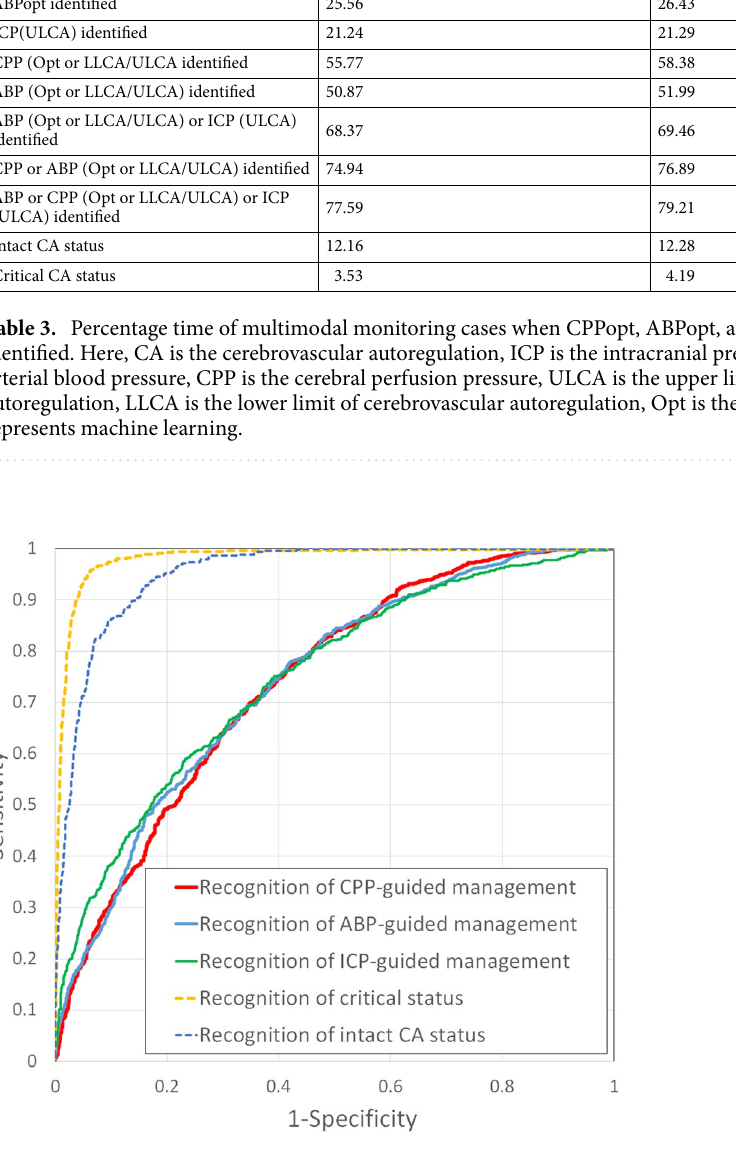
Figure 5. Representation of the diagnostic ability of the developed ML model to recognize CPP-, ABP- or ICP-guided management, as demonstrated by the receiver operating characteristic (ROC) curves. ROC characteristics for recognition CPP-guided management: sensitivity 68%, specificity 66%, AUC 0.74; ABP- guided management: sensitivity 51%, specificity 81%, AUC 0.74, ICP-guided management: sensitivity 31%, specificity 89%, AUC 0.75; recognition of critical status: sensitivity 87%, specificity 97%, AUC 0.98; recognition of intact CA status: sensitivity 77%, specificity 94%, AUC